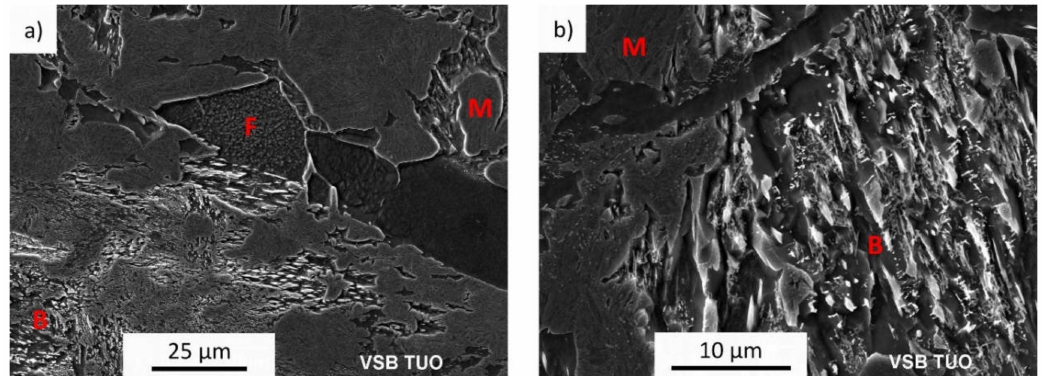
Figure 7. SEM analysis of a sample quenched from a heating temperature of 770 ◦ C. ( a ) Three structure constituents—bainite ( B ), ferrite ( F ) and martensite ( M ); ( b ) close-up view of bainite and martensite.